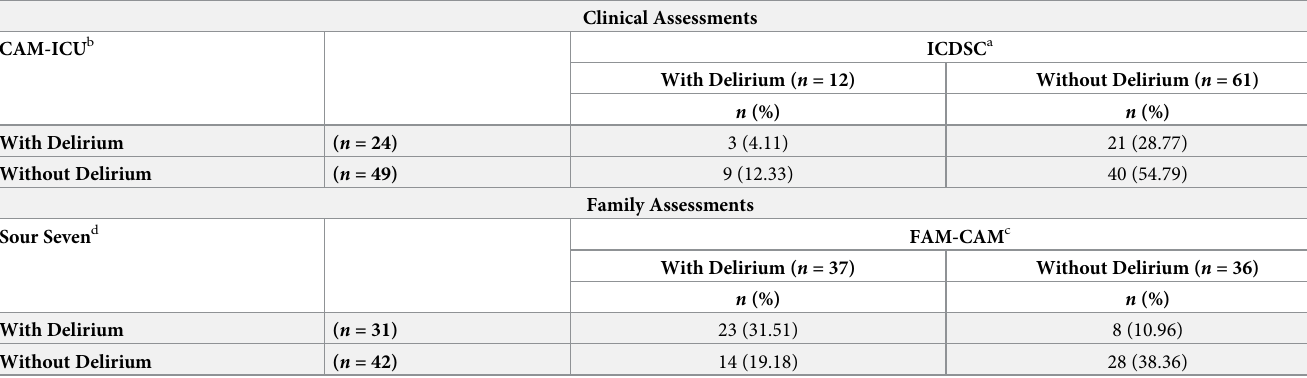
Table 2. Patient delirium assessment results, paired.